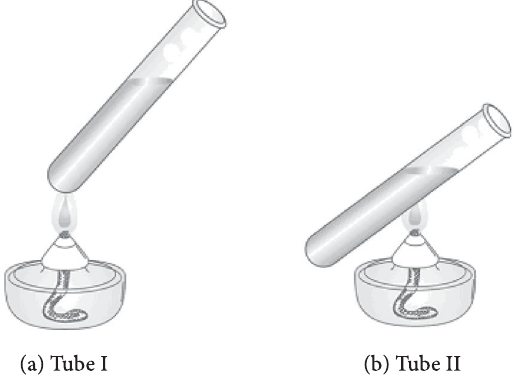
FIG. 1. An example of the interview questions in the second